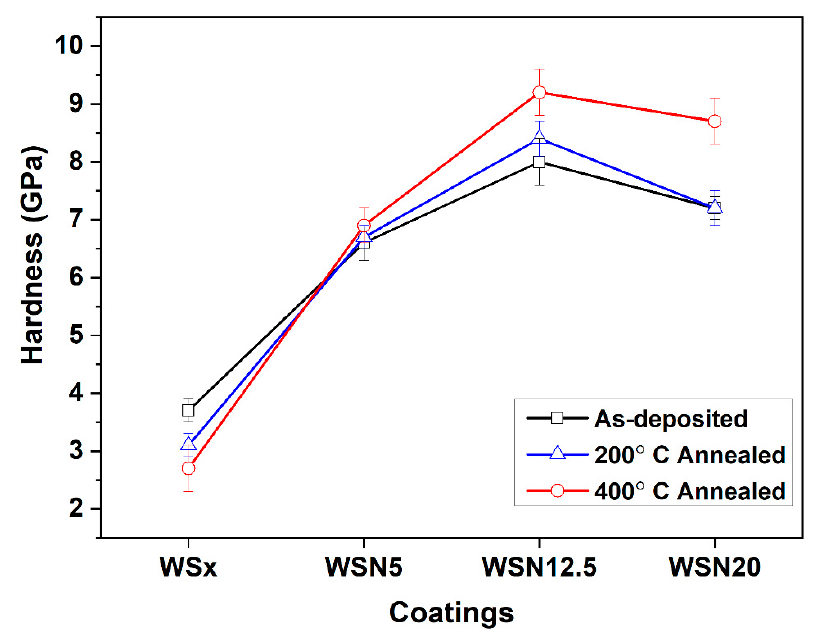
Figure 4. Hardness of the as-deposited and annealed coatings.